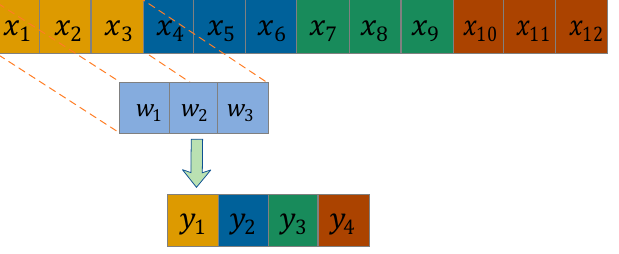
Figure 4. 1D-CNN convolution process.